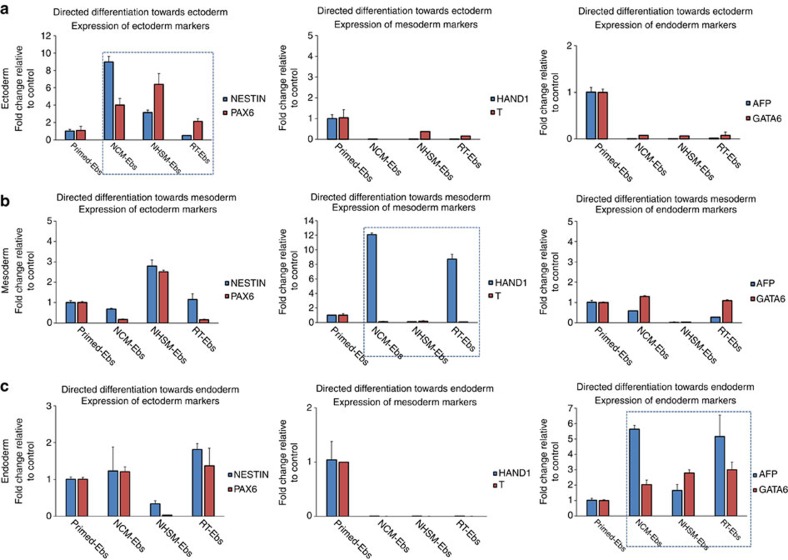
Germ-layer specific differentiation of naive hESC line UGent11-70.Gene expression analysis for lineage-specific genes upon directed differentiation of naive hESC line UGent11-70 towards (a) ectoderm, (b) mesoderm and (c) endoderm. All germ layer markers were analysed irrespective of the targeted lineage to determine the heterogeneity in differentiation between the different naive medium conditions as well as between primed and naive conditions. Dashed box represents the gene expression for markers specific for that lineage. The data are represented as mean±s.d.